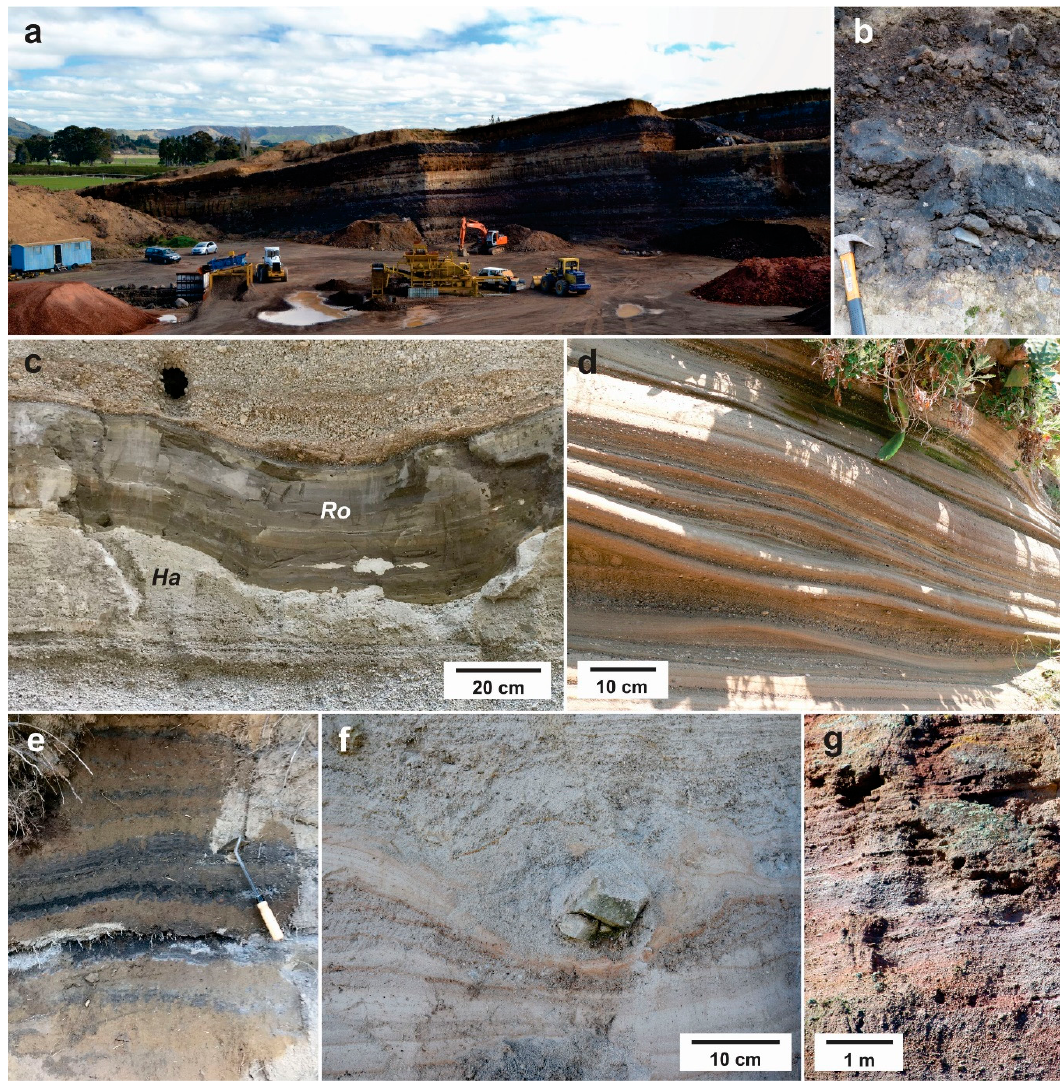
Figure 2. Deposits relating to different hydrovolcanic eruption styles in monogenetic and polygenetic volcanic systems: ( a ) – Deposits formed by alternating water-influenced Strombolian and phreatomagmatic eruptions at a satellite vent (Ohakune Volcanic Complex) of Ruapehu volcano, New Zealand; ( b ) – Cauliflower-shaped bombs in Strombolian beds suggest some influence of magma-water interaction at the Ohakune Volcanic Complex, New Zealand; ( c ) – Phreatoplinian Hatepe (Ha) and Rontongaio (Ro) ash of the 232 AD Taupo eruption, New Zealand ( d ) – Accretionary lapilli bearing surge deposits in Lipari, Italy; ( e ) – Distal ash layers of dominantly phreatomagmatic layers of Tufa Trig Formation, Ruapehu volcano, New Zealand; ( f ) – Silicic phreatomagmatic beds with impacted rhyolite lava bomb at Puketerata Volcanic Complex, Taupo Volcanic Zone, New Zealand; ( g ) – Deposits of fall-dominated silicic Surtseyan-like emergent eruptions of the Motuoapa Peninsula, Taupo Volcanic Zone, New Zealand [149].